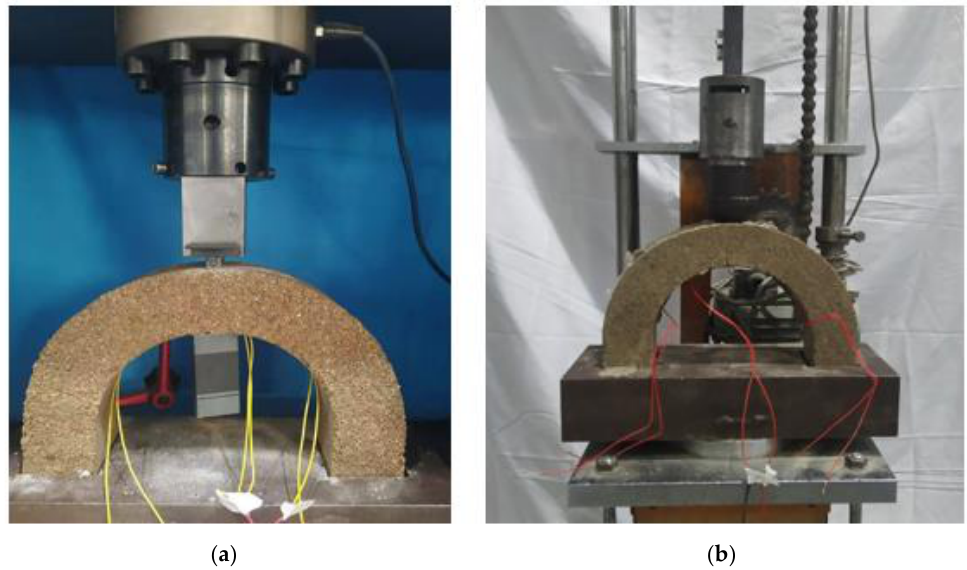
Figure 3. Test setup for U-shaped specimen under ( a ) static and ( b ) drop-weight impact test.